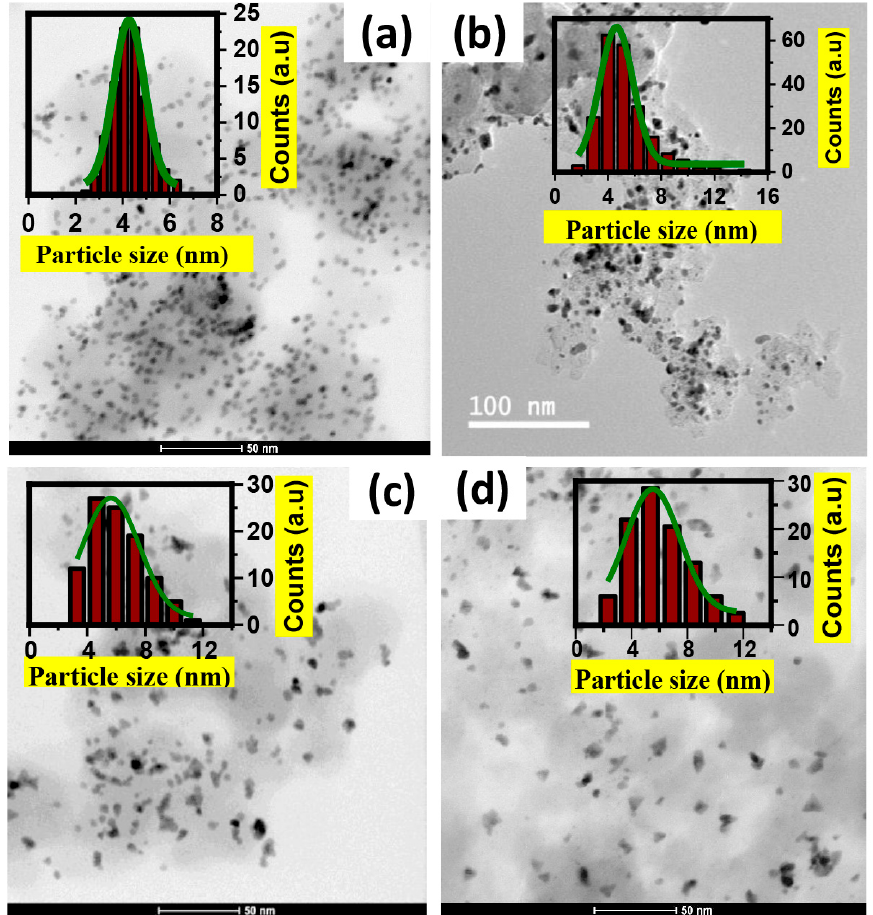
Figure 3. Images and histograms of particle size distribution of Pt/C ( a ), Pt/4CeO 2 /C ( b ), Pt/6CeO 2 /C ( c ), and Pt/8CeO 2 /C ( d